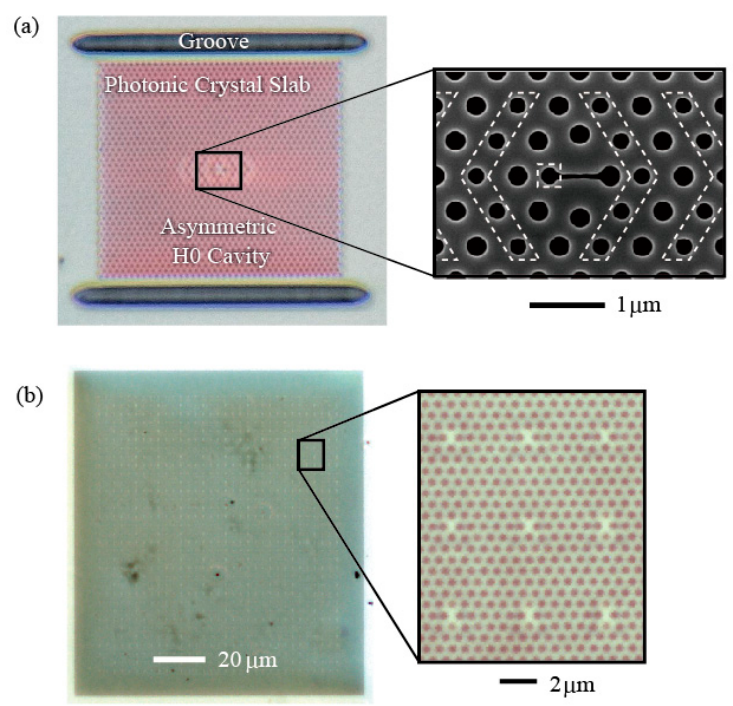
Figure 3. Top view of fabricated GaInAsP PC nanolasers. ( a ) Single device with asymmetric H0 type nanocavity structure and a nanoslot. The dotted line in the magnified view shows areas in which hole sizes were reduced. ( b ) Arrayed device.